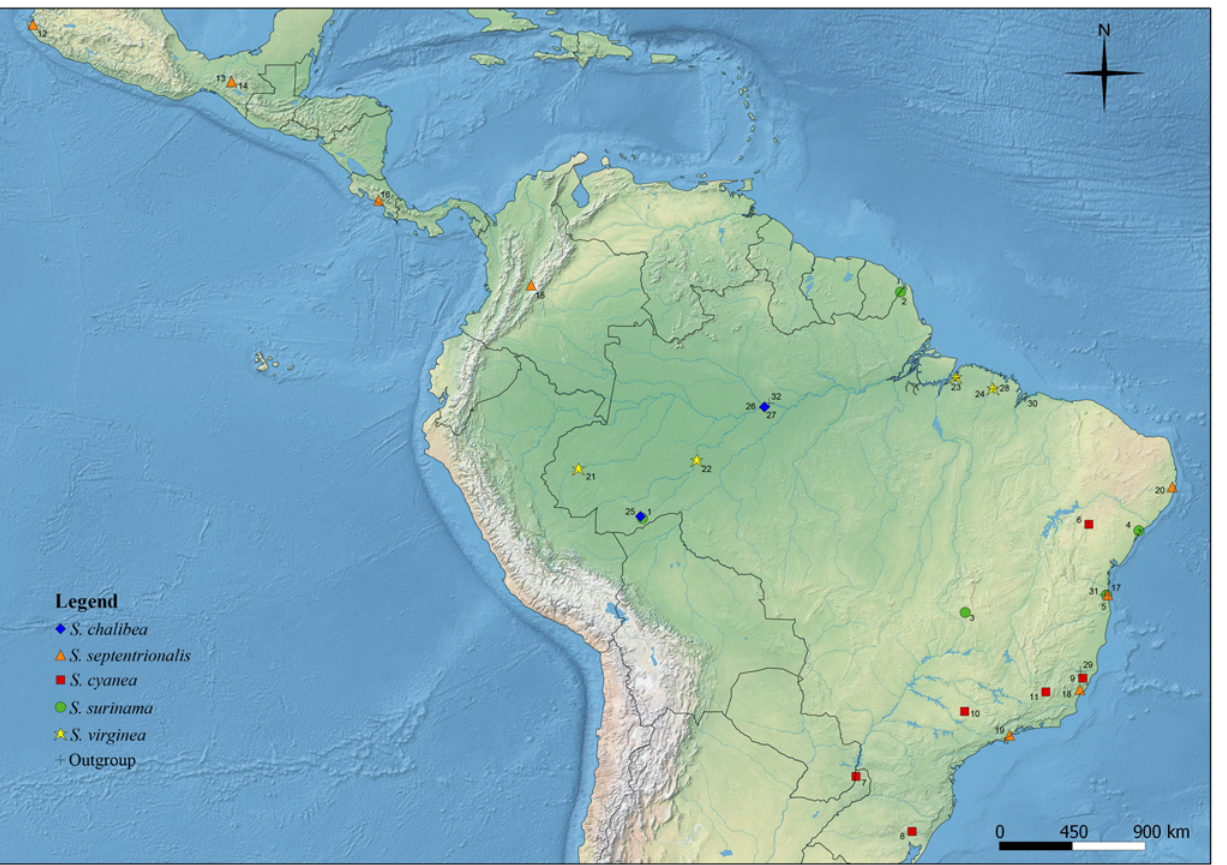
Fig 1. Map showing collection sites. The numbers refer to the sampling locality codes shown in Table